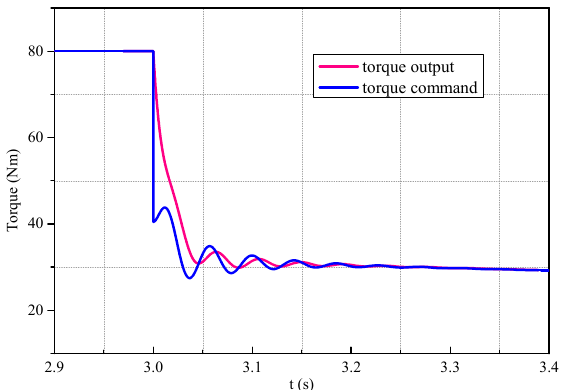
Figure 9. Torque output of permanent magnet synchronous motor (PMSM).